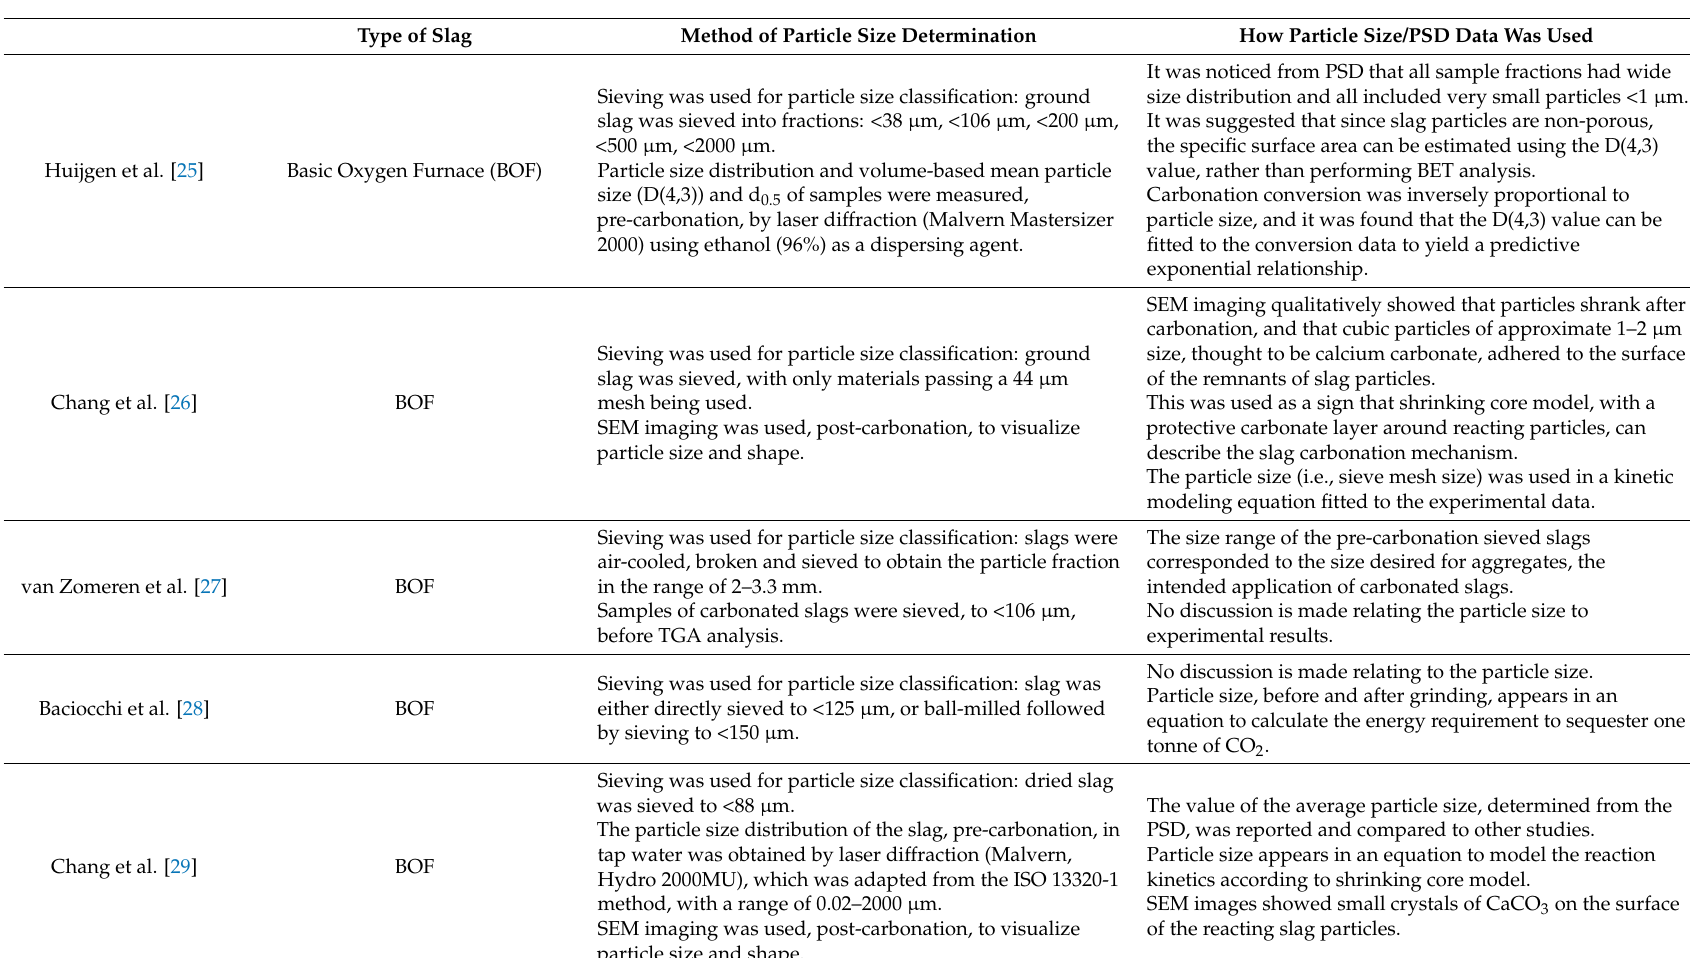
Table 3. Summary of particle size determination methods and utilization from different carbonation studies reviewed by Georgakopoulos et al.